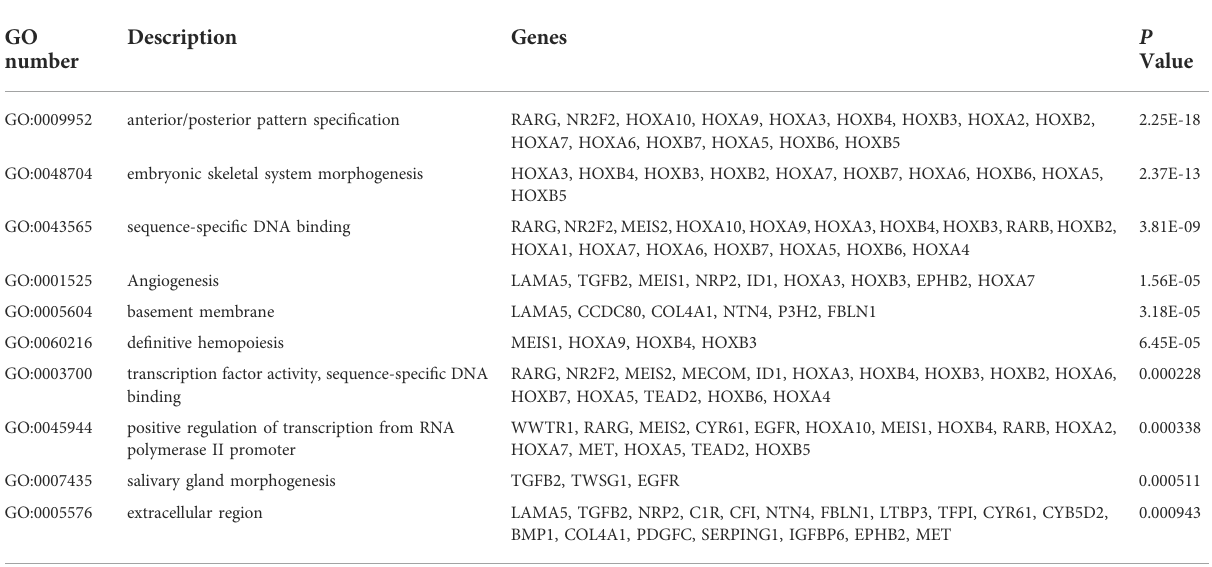
TABLE 4 Gene ontology analysis of HOXA-AS2-related